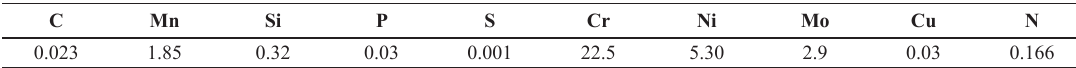
Table 1. Base metal composition (wt. %).